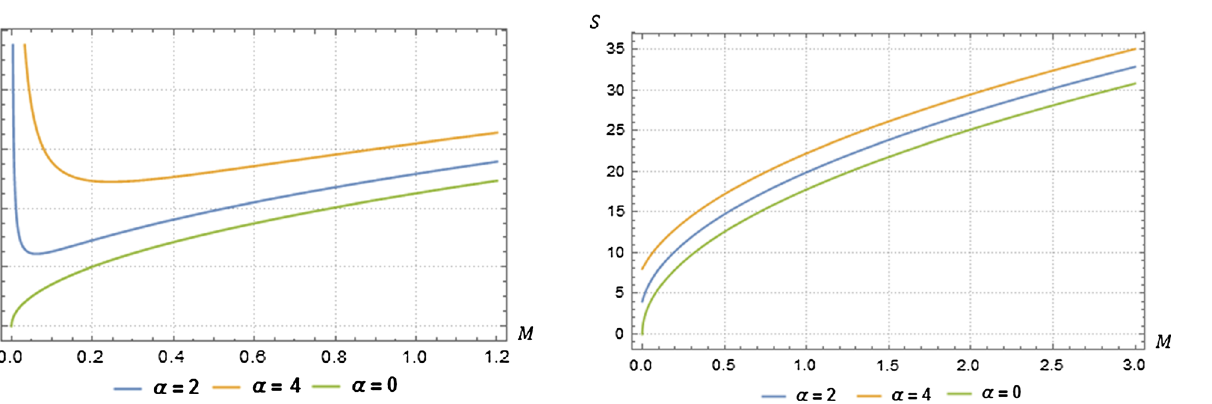
Fig. 1 A plot of the BTZ temperature and its mass for a fixed l = 0 . 5 in Planck units. Observe how quantum corrections lead to a significant increase of temperature at low masses (small scale). Here quantum fluctuations are expected to be most prominent